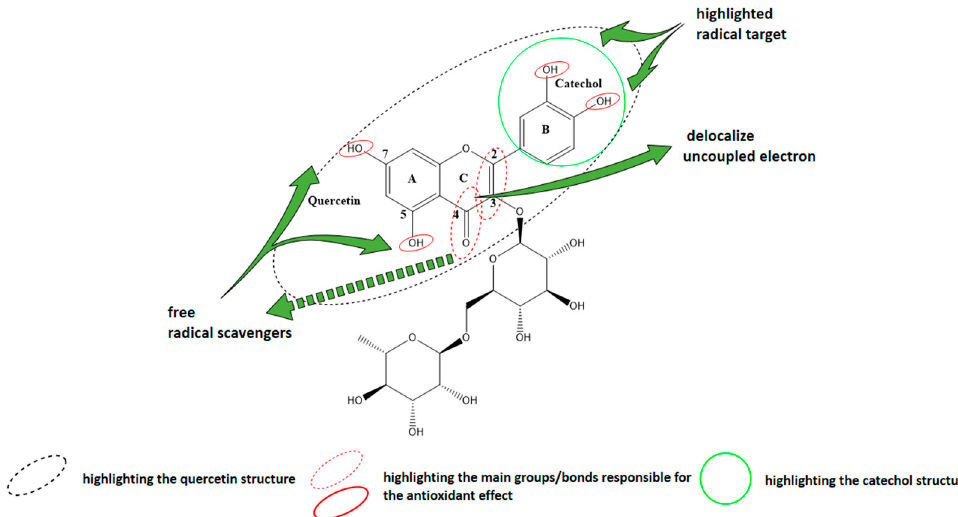
Figure 1. Chemical structure of rutin (Rut) highlighting the functional groups responsible for the antioxidant effect.